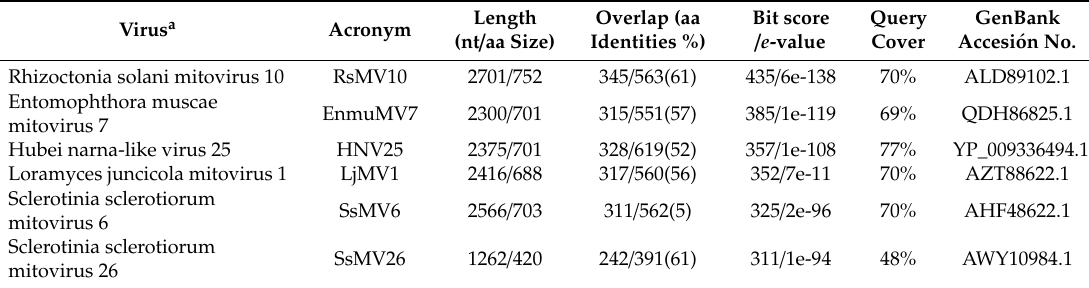
Table 2. Results from BlastX homology search with Fusarium oxysporum f. sp. dianthi mitovirus